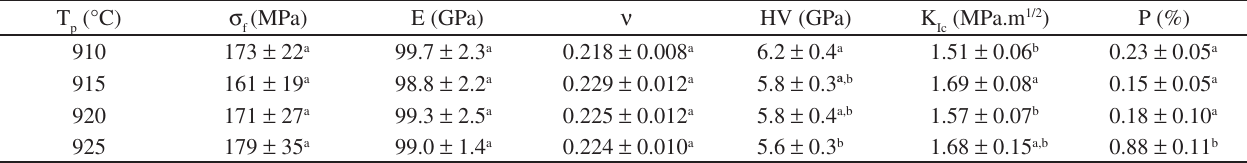
Table 2. Mean ± standard deviations for biaxial flexural strength ( σ ) in artificial saliva at 37 °C, Young’s modulus (E), Poisson’s coefficient ( ν ), Vickers hard- f ness (HV), fracture toughness (K ) and volume fraction of porosity (P) for the different pressing temperatures (T Ic followed by the same superscript are statistically similar (p > 0.05).